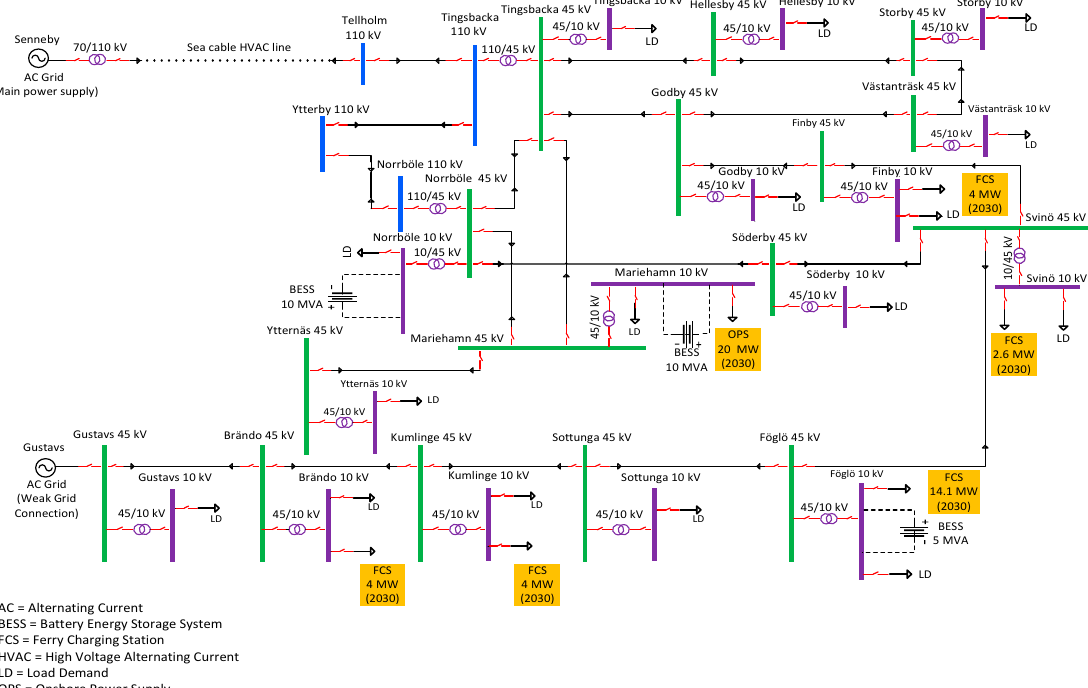
Figure 16. Meshed mode operation of the electricity network in the Åland Islands for the year 2030 with BESSs.